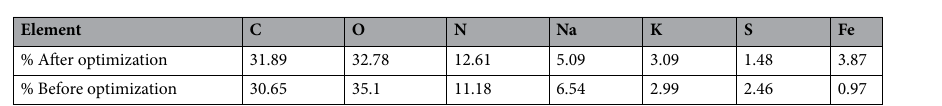
Figure 18. EDX Spectra showing iron percentage in prepared samples before ( a ) and after ( b ) employing optimization process.